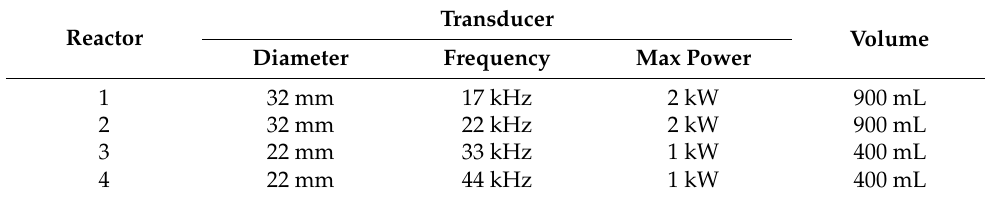
Figure 3. ( a ) A schematic illustration of a reactor component in cavitation testing. ( b ) An experi- mental setup. Table 1. Parameters of reactor components. Table 1. Parameters of reactor components.